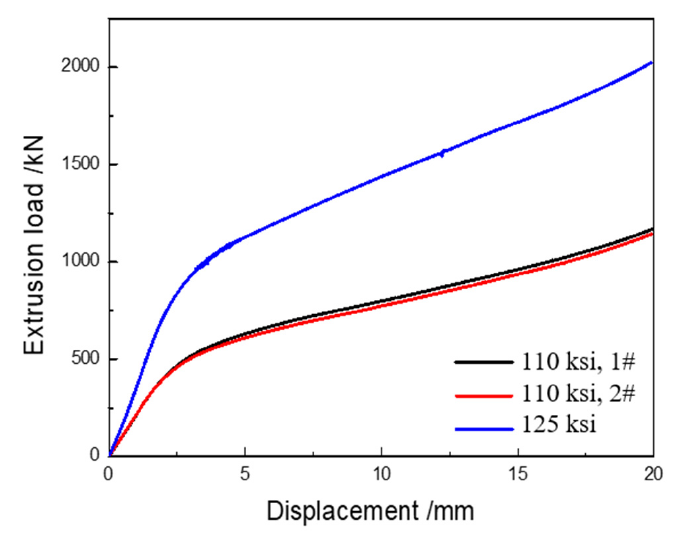
Figure 11. Extrusion load and displacement curve of casing.